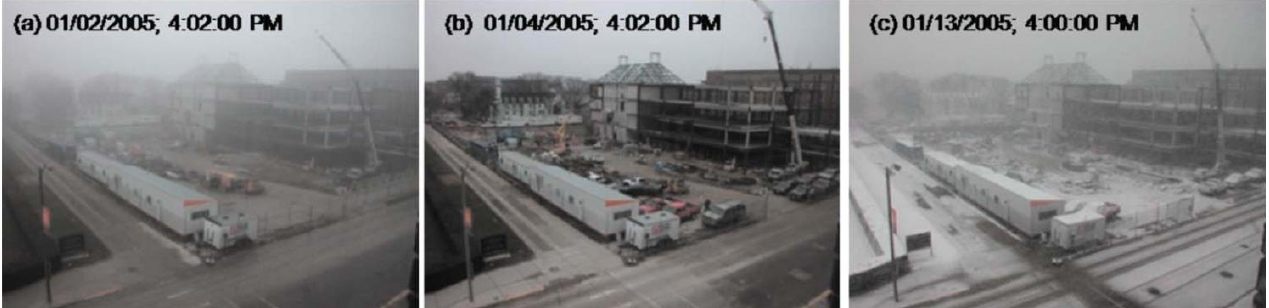
Figure 10. Different weather conditions during a construction project: ( a ) fog; ( b ) rainy; and ( c ) snow [33].